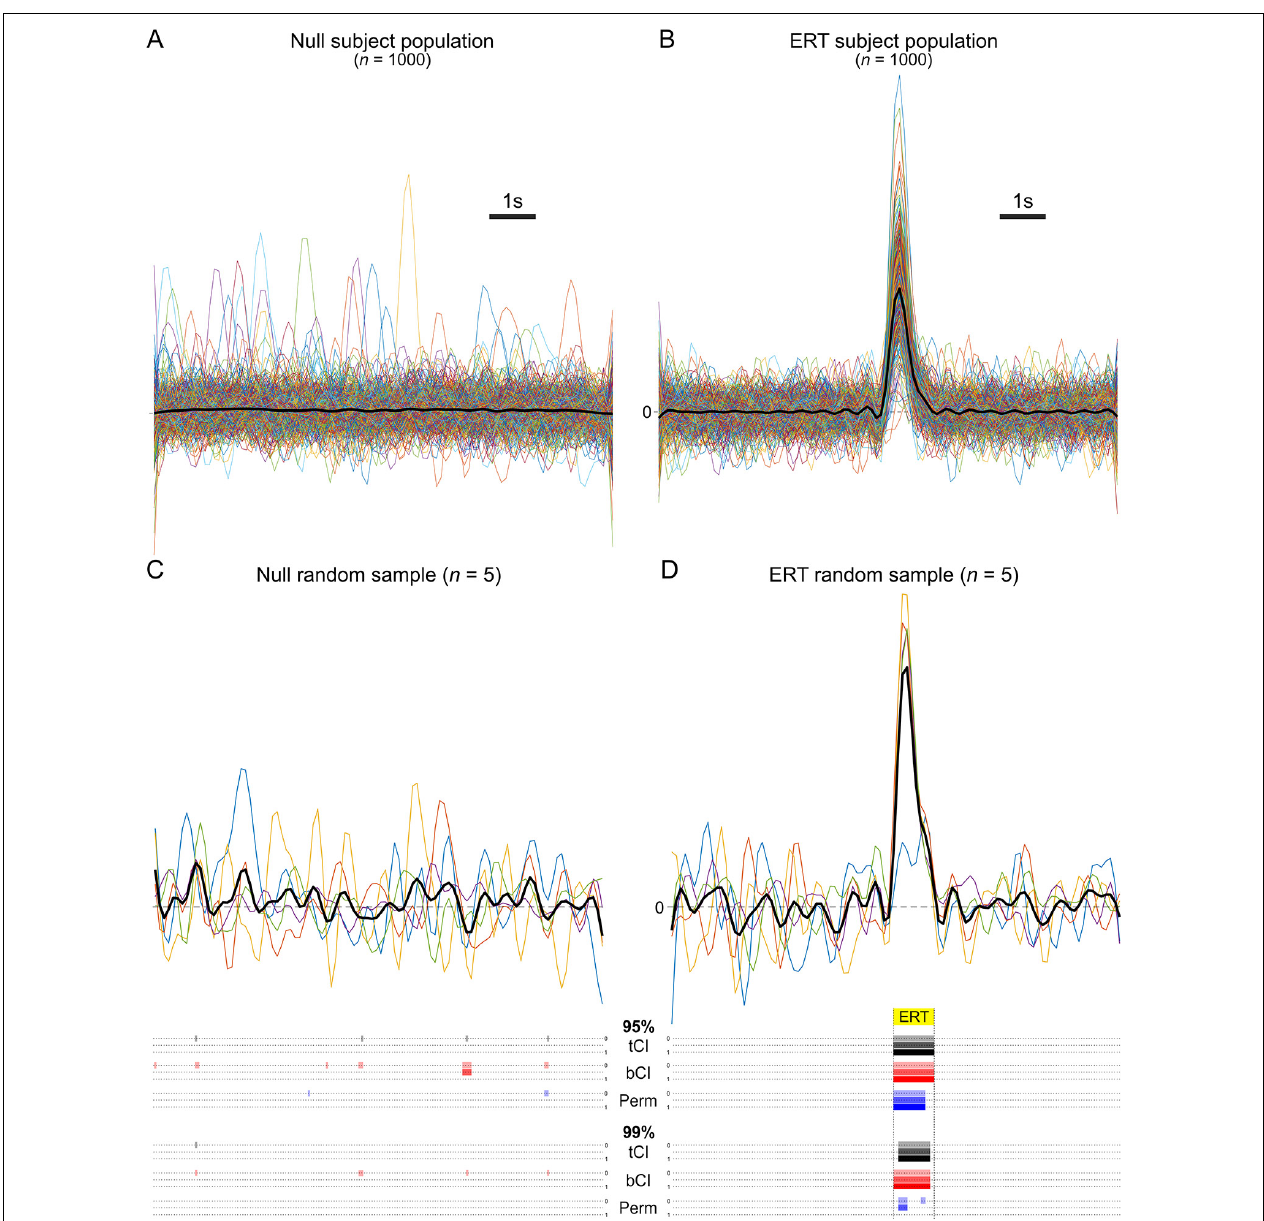
FIGURE 2 | (A,B) Population of mean subject waveforms. (C,D) Example run [sample n = 5 (colored lines; mean = black line)] from Monte Carlo simulation and results of various analyses [parametric t interval (tCI), bootstrapped confidence interval (bCI), permutation test (Perm)] at 95% and 99% significance levels. (C) Example run when sampling from the null population. Colored bars beneath sample traces indicate where significant differences from null were incorrectly detected (Type I error), per analysis method. Without a consecutive threshold (top dotted line/colored bars per method), all analysis methods detected significant deviations from null at the 95% level; each produced Type I errors. A consecutive threshold (low-pass frequency window) prevented this error (bottom dotted line/colored bars per method). (D) Example run when sampling from event-related activity transients (ERT) population. Colored bars beneath sample traces indicate where in the ERT period (yellow highlighted period) significant differences from null were correctly detected, per analysis method. At the 95% level, tCI and bCI correctly rejected the null for the full extent of the ERT period, while the permutation test correctly rejected 80%. Consecutive thresholds did not impact this finding. At the 99% level, a smaller proportion of the ERT was identified. Importantly, the permutation test failed to meet the full low-pass consecutive threshold, and thus failed to identify a significant transient (Type II